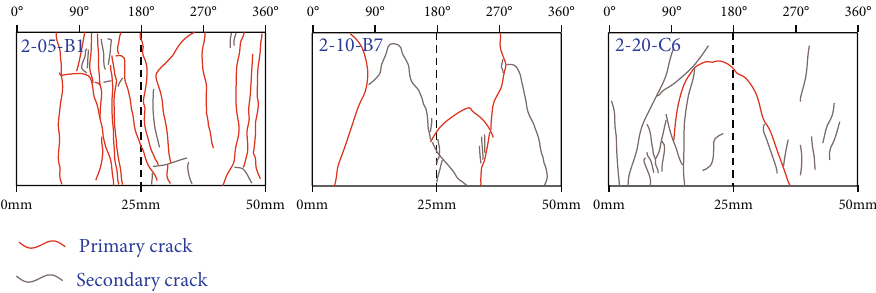
Figure 8: Sketch of fractures after failure of Scheme 2 under di ff erent con fi ning pressures.